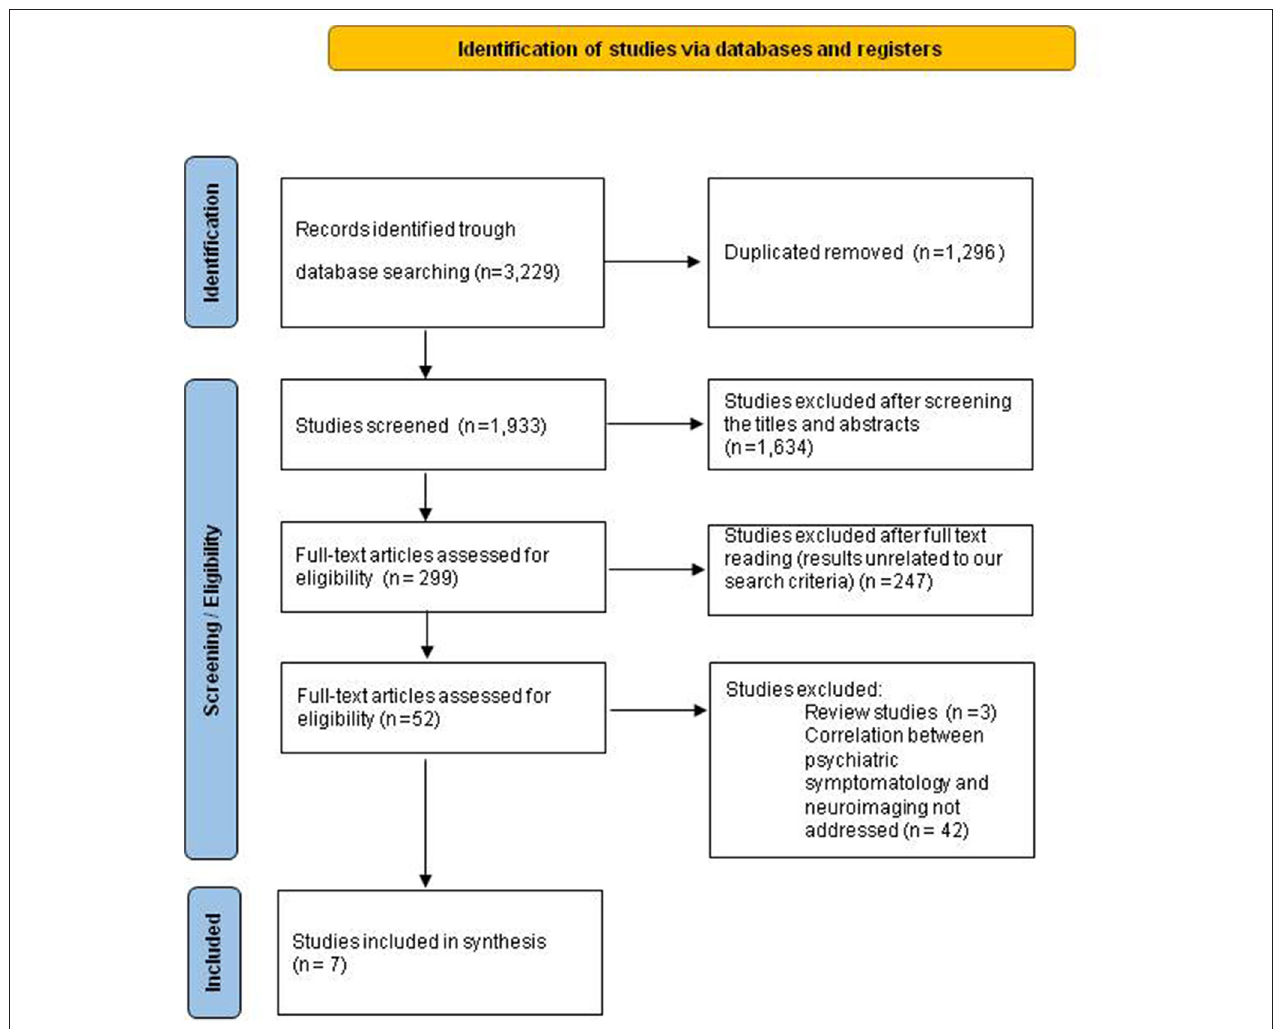
FIGURE 1 | Diagram for identification and selection of